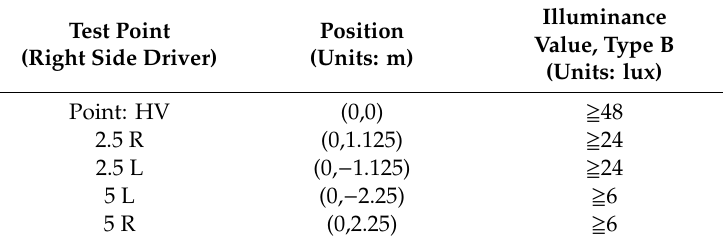
Table 1. ECE R-112 high-beam test specification.